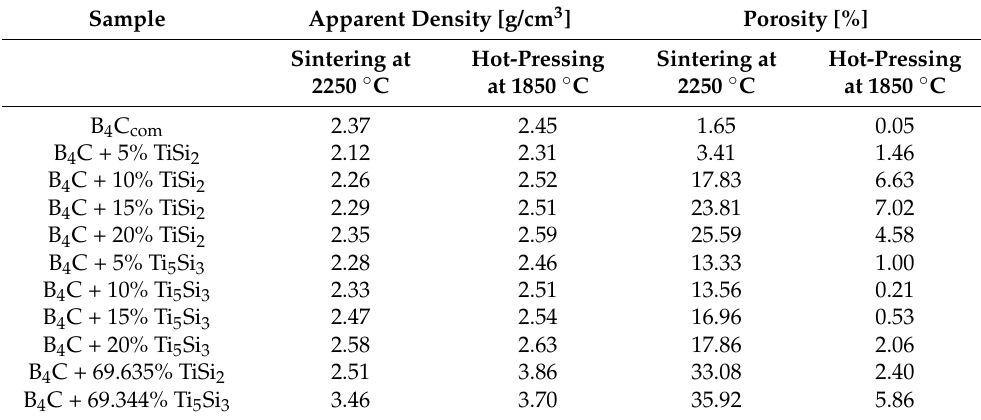
Table 1. Apparent density, porosity calculated values, and the phase composition of B 4 C with TiSi 2 and Ti 5 Si 3 fabricated at 2250 °C and hot-pressing (HP) at 1850 °C.